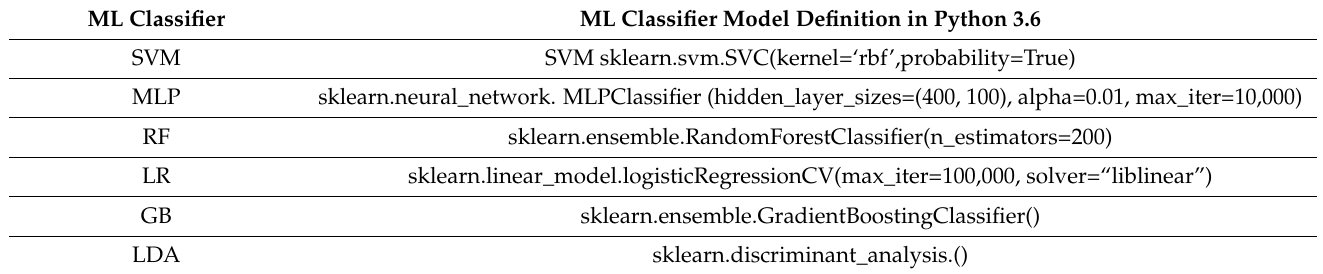
Table 1. The different ML classifiers with their definitions.